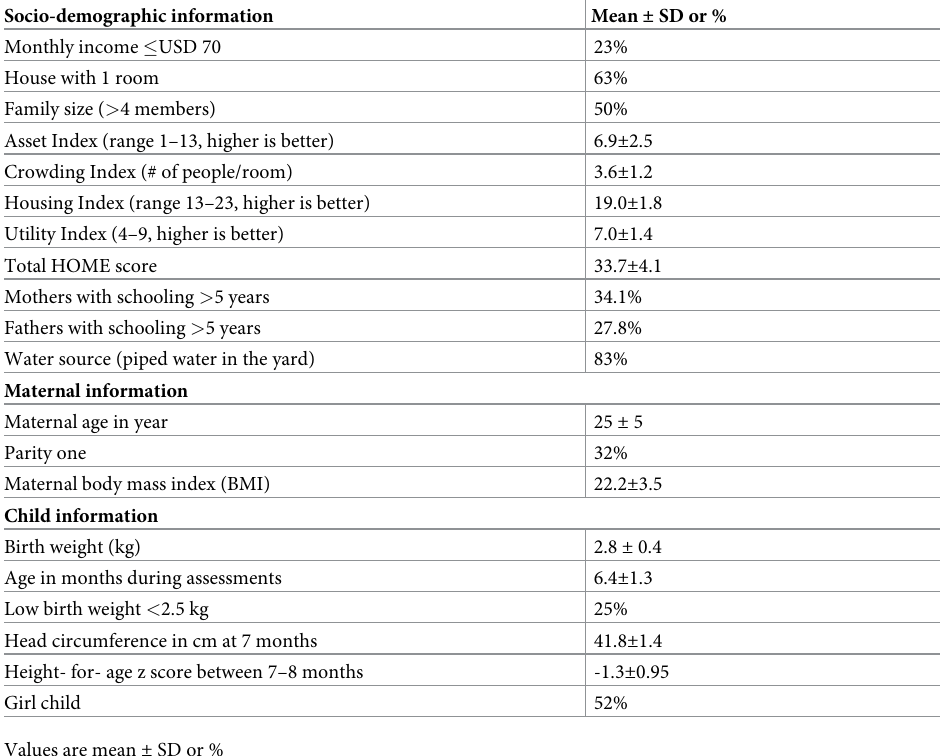
Table 1. Baseline characteristics of the study population (n =